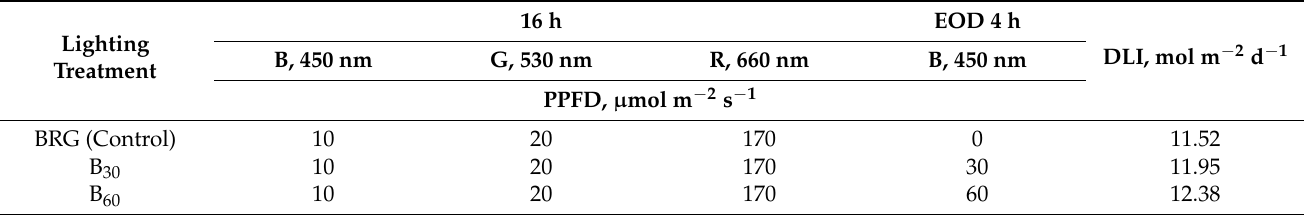
Table 1. Photon distribution of sole-source lighting for lighting treatments used in